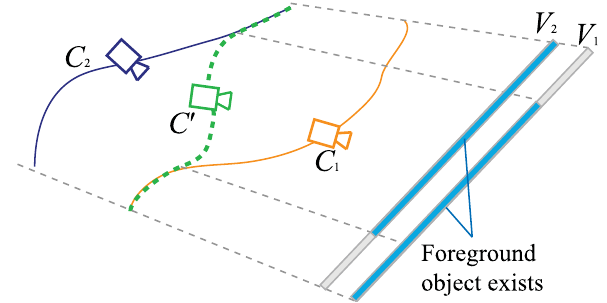
Fig. 5 We would like to find a new camera path C (cid:2) (shown in green) which can transition from camera C 1 (shown in orange) to camera C 2 (shown in blue). For the video generated along camera C (cid:2) , the content should be the same as video shot V 1 at the start of when the foreground object is visible in both cameras and match video V 2 at the end of this period.